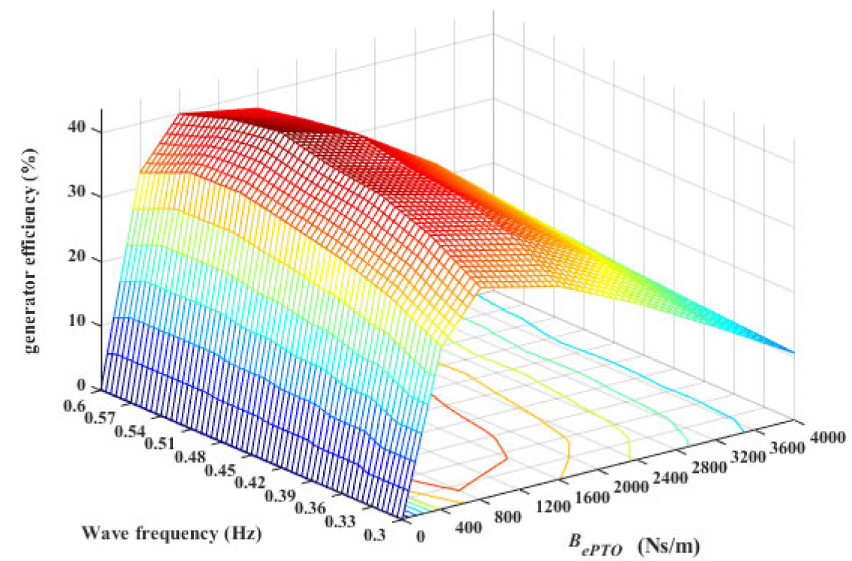
Figure 18. Generator efficiency when adjusting damping ( B ePTO ), H = 0.2 m, f = 0.3 to 0.6